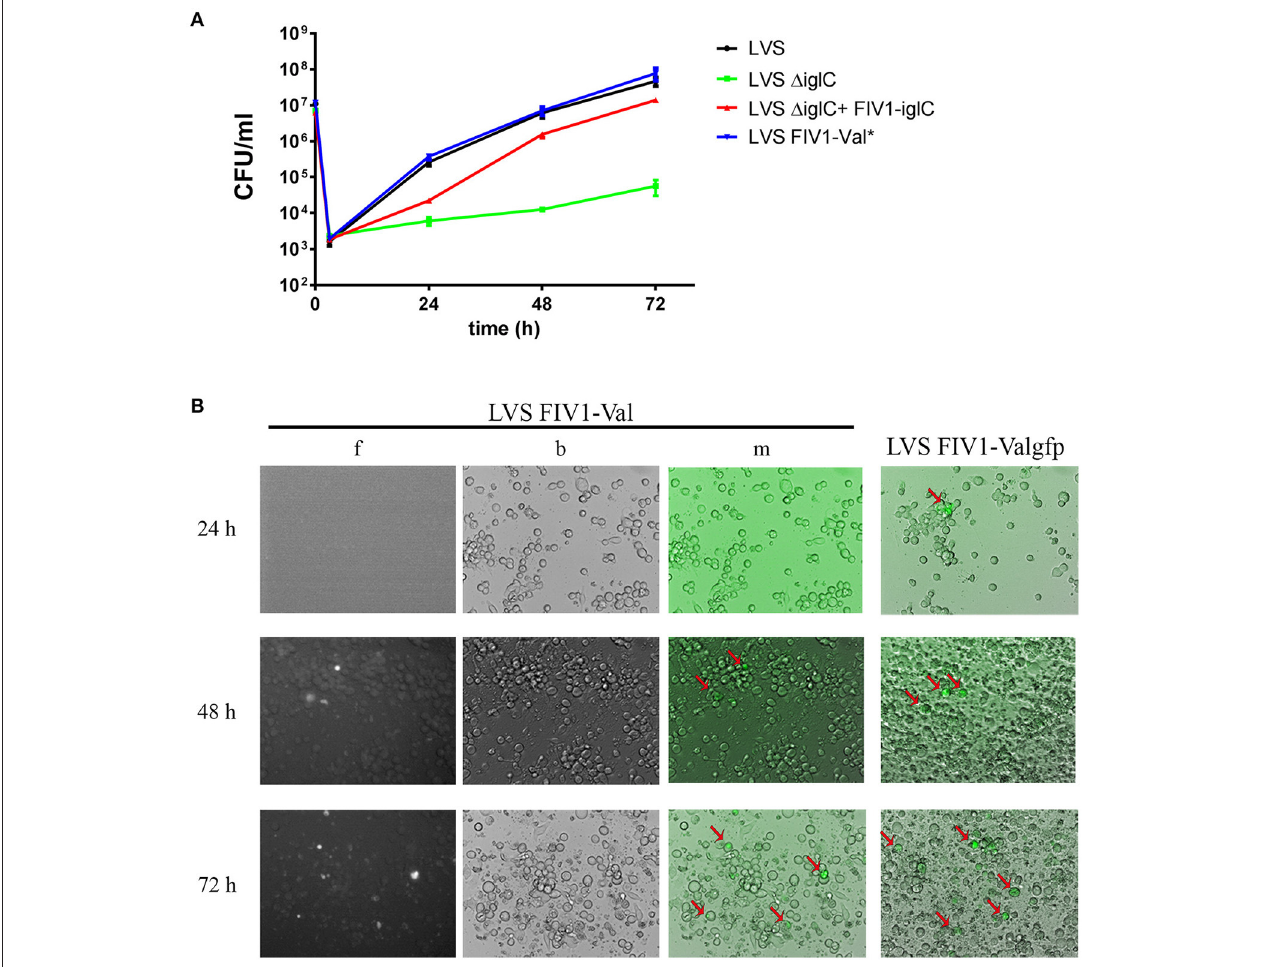
FIGURE 4 | Infection assays using a human macrophage-like cell line (U937). (A) Replication of Fth LVS wild type (LVS), Fth LVS iglC mutant (LVS 1 iglC), complemented Fth LVS iglC mutant (LVS 1 iglC + FIV1-iglC) and Fth LVS wild type containing FIV1-Val (LVS FIV1-Val). Cells were infected at an MOI of 10, and CFU was determined by plating on HCA agar every 24h. Results are mean standard deviations of duplicate samples and are representative of at least 3 independent experiments. *, done only twice. (B) Fluorescence microscopy of U937 cells infected with Fth LVS FIV1-Val or Fth LVS FIV1-Valgfp. f, fluorescence; b, bright field; m,